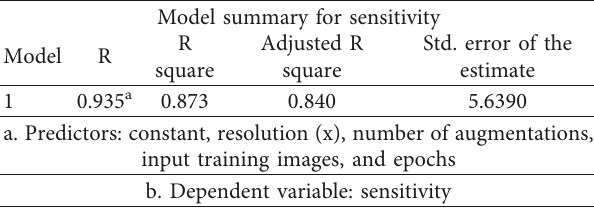
Table 5: Model summary output for accuracy. Model summary for